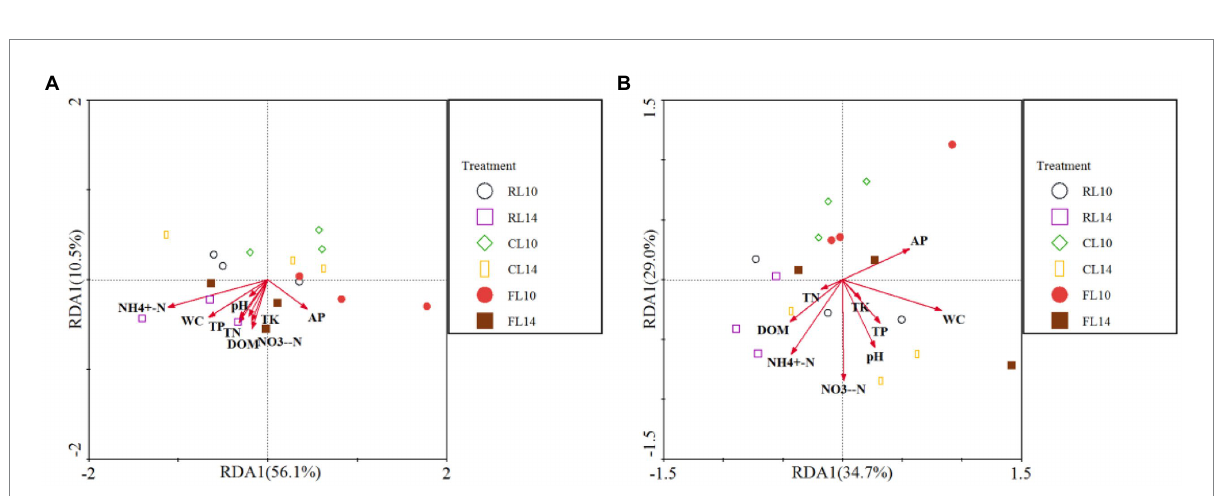
FIGURE 2 Redundancy analysis (RDA) of soil properties and bacterial community (phylum level). (A) is the R1 growth stage, (B) is the R6 growth stage. RL10, L10 under CR treatment; RL14, L14 under CR treatment; CL10, L10 under CC treatment; CL14, L14 under CC treatment; FL10, L10 under CF treatment; FL14, L14 under CF